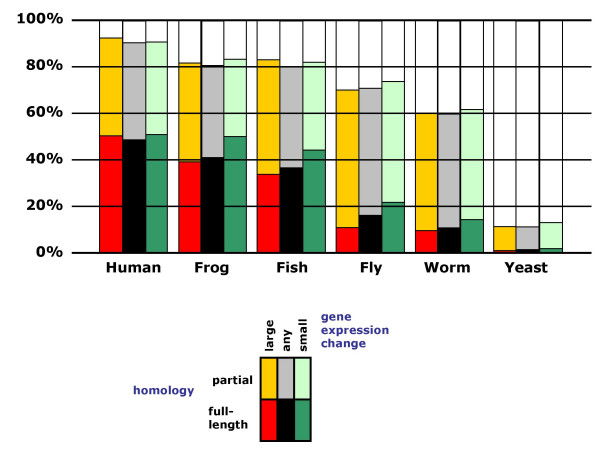
Phylogenetic distribution of proteins associated with probe sets. Percentage of proteins with homologues in a given organism: Homo sapiens (human), Brachydanio rerio (fish), Xenopus laevis (frog), Drosophila melanogaster (fly), Caenorhabditis elegans (worm), and Saccharomyces cerevisiae (yeast). For each organism, the leftmost column indicates homologues found for proteins from the 1,675 probe sets with largest gene expression changes, the middle column those from the complete set of 16,752 probe sets, and the rightmost column those from the 1,675 probe sets with smallest gene expression changes. In each column, the dark bottom part indicates the percentage of proteins aligned along their full length (less than 30 amino acids unmatched at the N- and C-termini of both sequences), and the lighter upper part is the percentage of proteins with sequence similarity (no length restriction). Proteins were considered similar with a BLAST E-value < 1e-6.